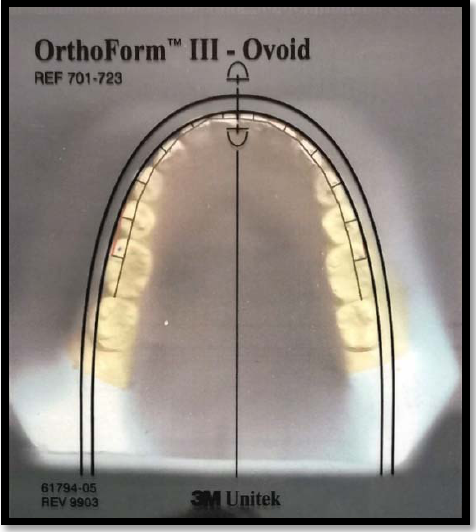
Figure 3. Superimposition of clear orthoform template on a printed digital model.